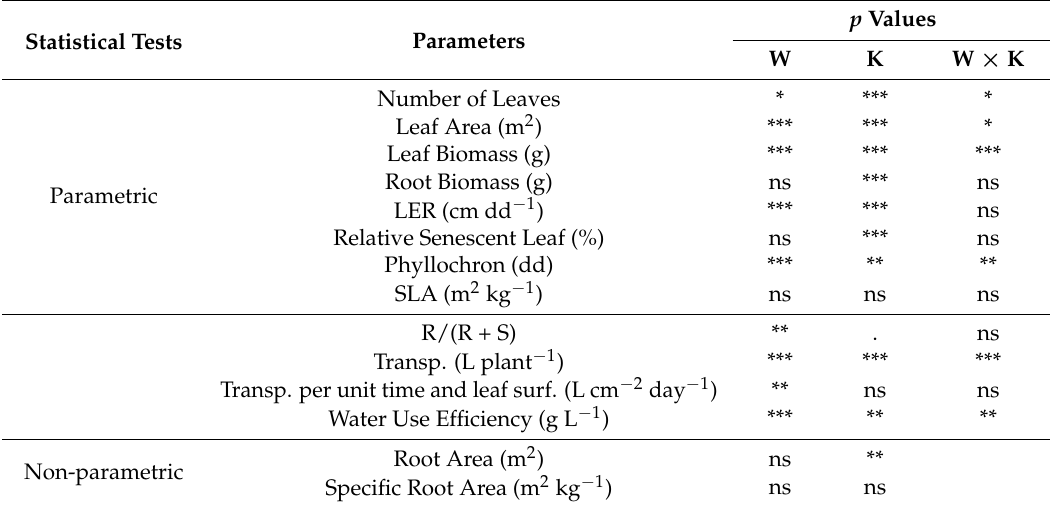
Table 1. Analysis of variance probability values for water (W) and potassium (K) fertilization treatments and their interactions (W × K) on corn ( Zea mays L.) morphological characteristics and on water transpiration and use